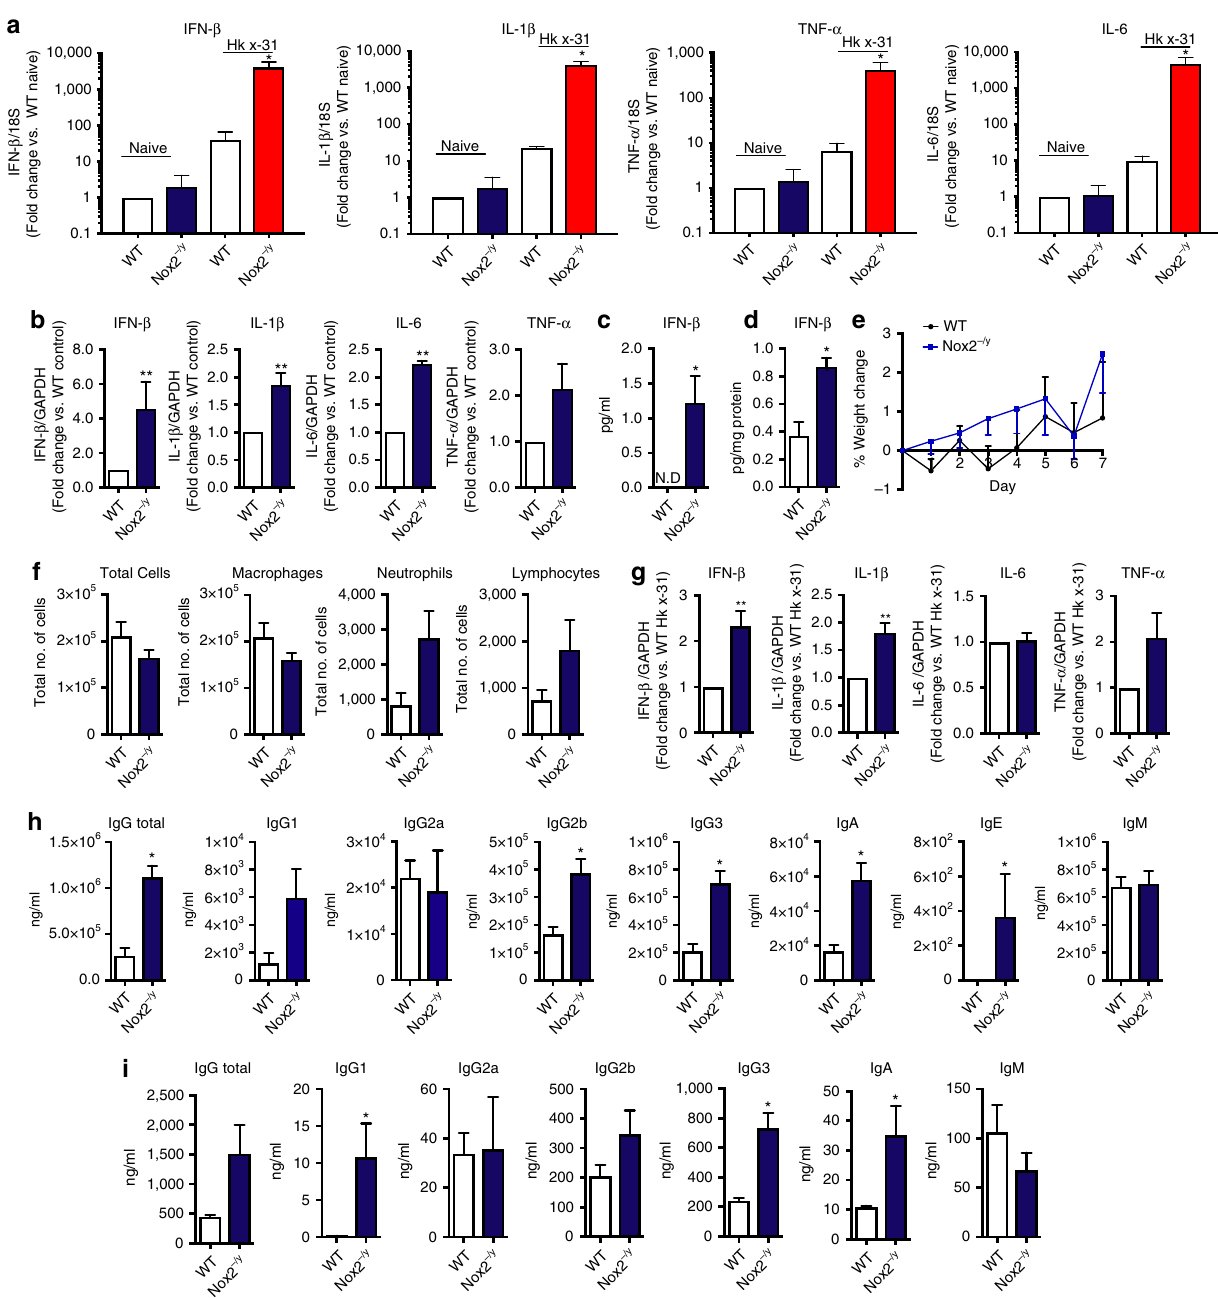
Fig. 8 Inhibition of NOX2 oxidase increases expression of Type I IFN and IL-1 β , and antibody production to in fl uenza A virus infection. a Alveolar macrophages from WT and Nox2 − /y mice were either left untreated (naïve) or infected with HKx31 in fl uenza A virus (MOI of 10) for analysis of IFN- β , IL-1 β , TNF- α , and IL-6 mRNA expression by QPCR after 24h ( n = 8). b , c WT and Nox2 − /y mice were infected with live HKx31 in fl uenza A virus (1 × 10 5 PFU per mouse) and b cytokine mRNA expression and IFN- β protein expression in c BALF or d serum were assessed 3 days later ( n = 5). e – i WT and Nox2 − /y mice were infected with inactivated HKx31 in fl uenza A virus (equivalent to 1 × 10 4 PFU per mouse) for measurements at day 7 of: e body weight; f airway in fl ammation and differential cell counts (i.e., macrophages, neutrophils, and lymphocytes); g cytokine expression in whole lung (responses are shown as fold change relative to GAPDH) and h serum and i BALF antibody levels ( n = 6). Data are shown as mean ± SE. a Kruskal – Wallis test with Dunn ’ s post hoc for multiple comparisons. b – i Unpaired t -test; statistical signi fi cance taken when the P < 0.05. * P < 0.05. ** P <